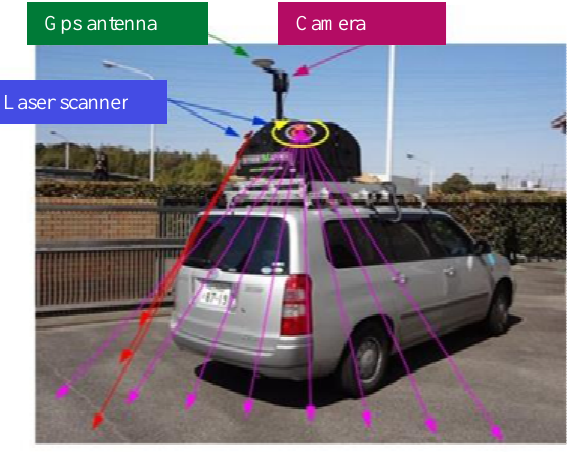
Figure3. MMS Vehicle Table 1 Specification of Measuring Vehicle